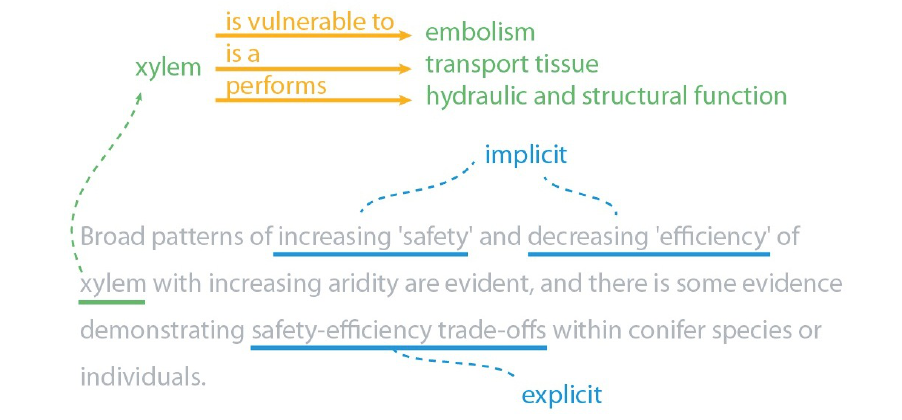
Figure 3. Example of a sentence that contains both an implicit and an explicit trade-off [77]. Automated extraction of trade-offs may take advantage of both. Furthermore, extracting information on concepts and relations in the text can provide a summary view, e.g., a term like xylem may